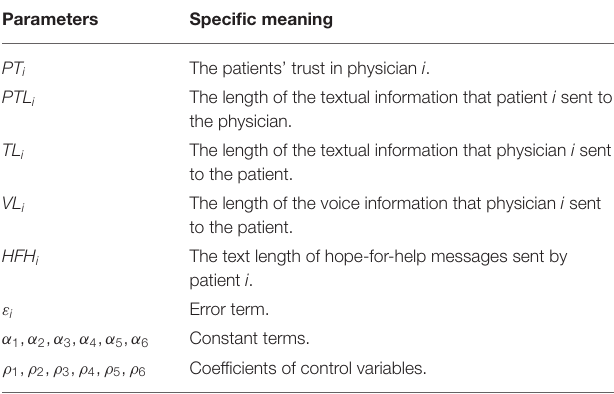
TABLE 2 | Specific meaning of parameters in models. Parameters